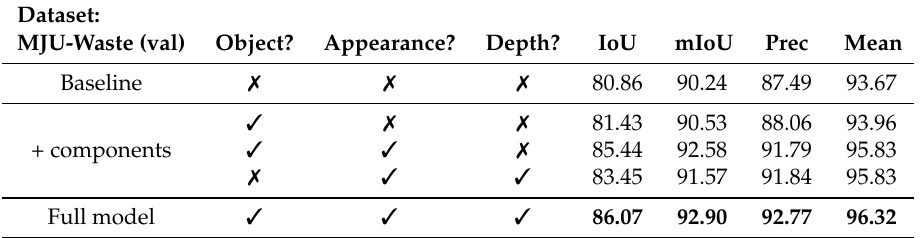
Figure 6. Example segmentation results on the MJU-Waste test set. Input images and ground-truth annotations are shown in the first two columns. Baseline methods are FCN-8s (VGG-16) and DeepLabv3 (ResNet-50). Our proposed methods (FCN-8s-ML and DeepLabv3-ML) more accurately recover object boundaries. Best viewed electronically, zoomed in. Table 4. Results from our ablation studies carried out on the validation set of MJU-Waste. The baseline method is DeepLabv3 with a ResNet-50 backbone. We add different components proposed in Section 3 individually to test their performance impact. See Section 4.3 for